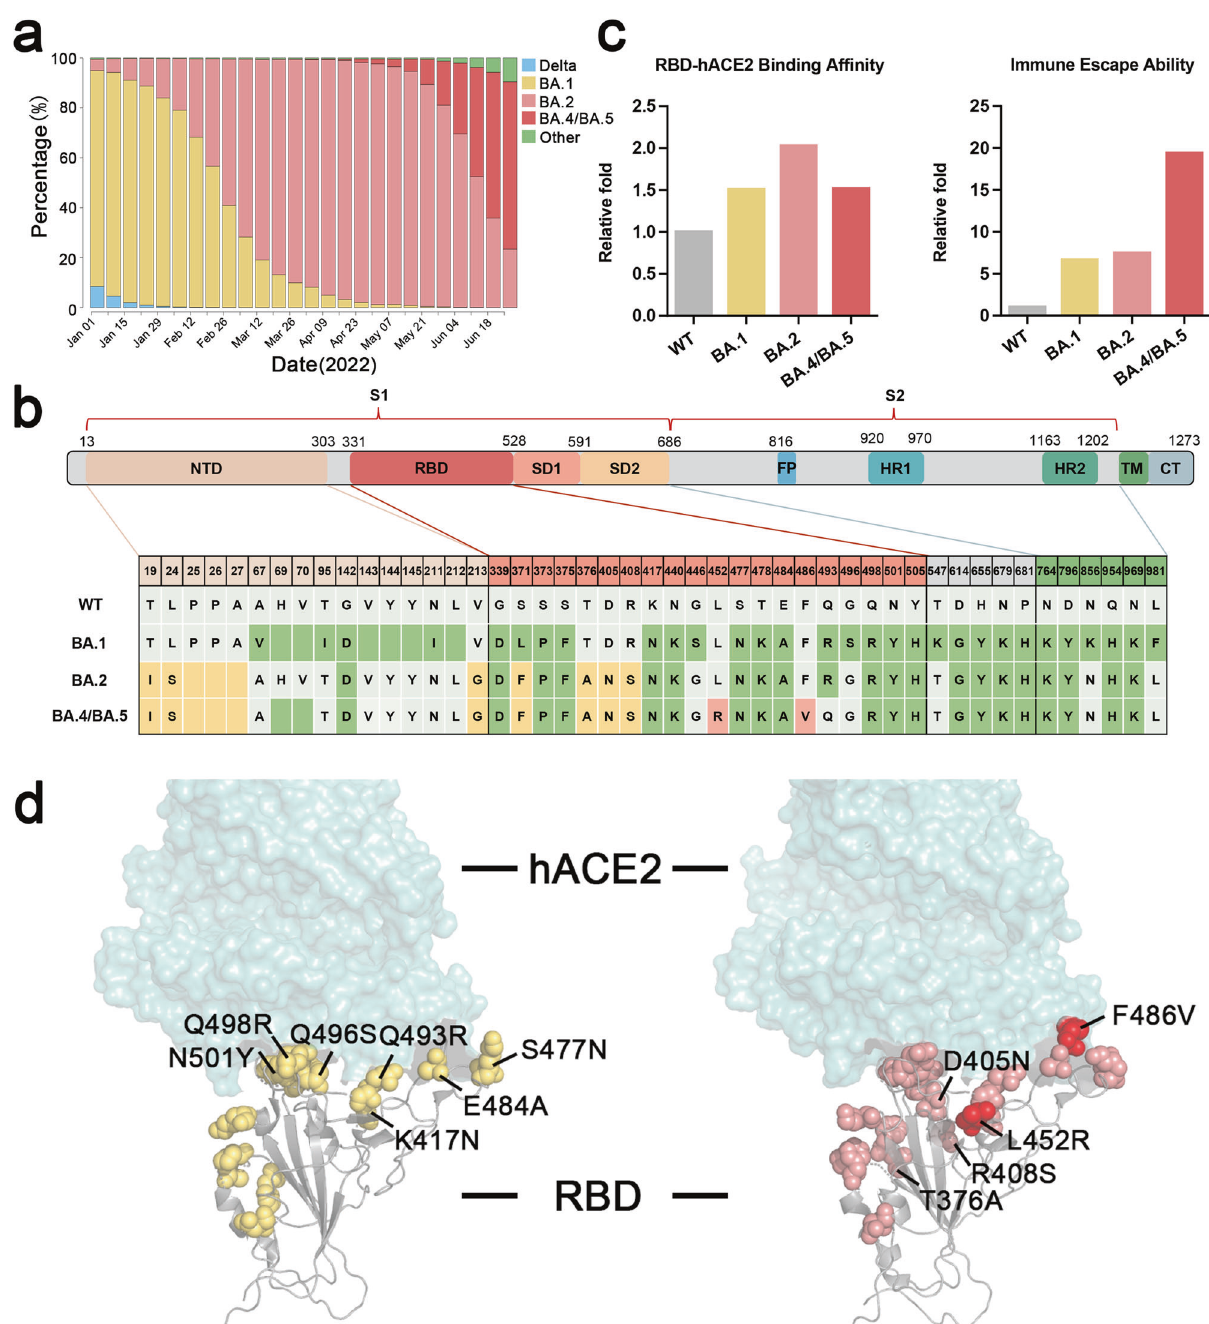
Fig. 1 Comparison of prevalence percentage, structure and mutations, binding af fi nity, and immune escape capacity of Omicron subvariants BA.1, BA.2, and BA.4/5. a Prevalence percentage of Omicron subvariants since January 1, 2022 (Variant distribution data are available in https:// covidcg.org/). b The mutations in the spike protein of Omicron subvariants BA.1, BA.2, and BA.4/BA.5, which are marked in different colors (green for new mutations in BA.1, yellow for new mutations in BA.2, pink for new mutations in BA.4/BA.5). c Comparison of RBD-hACE2 relative binding af fi nity and immune escape capacity among Wildtype (WT), BA.1, BA.2, and BA.4/BA.5. Data of binding af fi nity and immune escape capacity refer to the reported wet-bench data. 3,4 d Structure and mutation annotation of RBD binding with hACE2. Yellow for mutations in Omicron BA.1, pink for mutations in BA.2, and pink and red for mutations in BA.4/BA.5